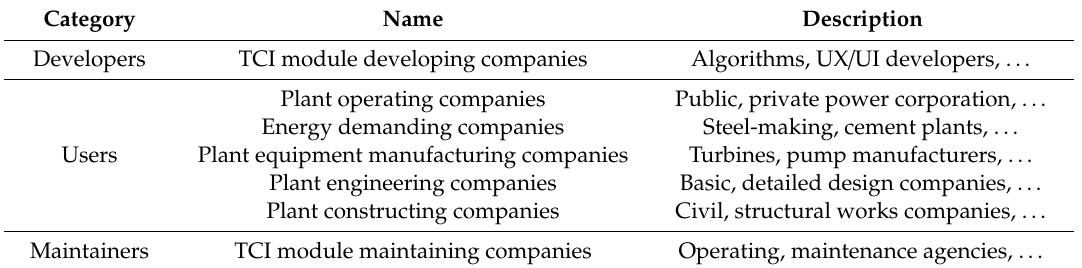
Table 3. Stakeholder identification of the total capital investment (TCI) estimation module.